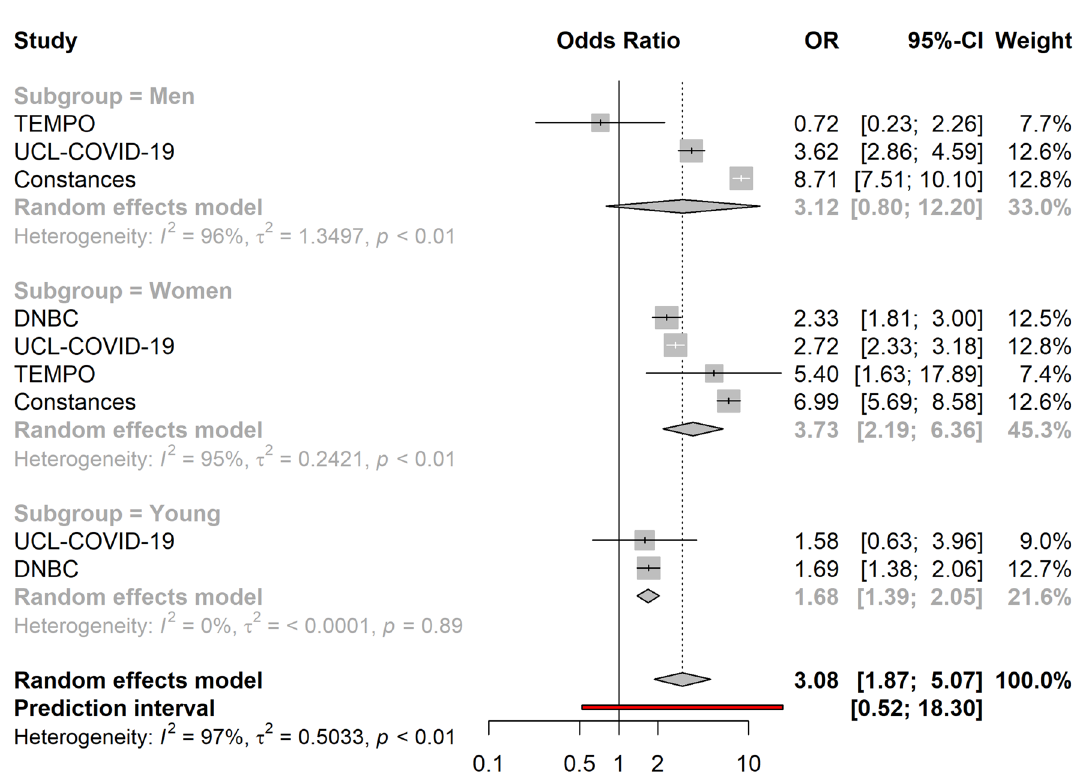
Figure 3. Association between household crowding and low life satisfaction (N = 18,652). The cohort-specific estimates and 95% confidence intervals were obtained using binary logistic regression models. Age, educational attainment, gender, previously diagnosed chronic disease status and presence of previously diagnosed mental illness were used a covariates. In addition, the models included mutual adjustment for the other housing exposures. 95% CI 95% confidence interval, OR odds ratio.